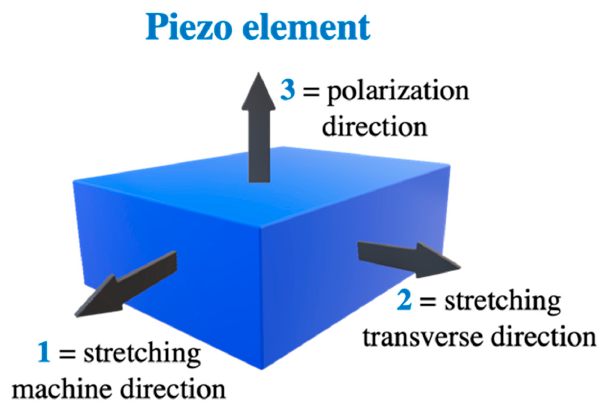
Figure 2. Axis definition of piezo element.